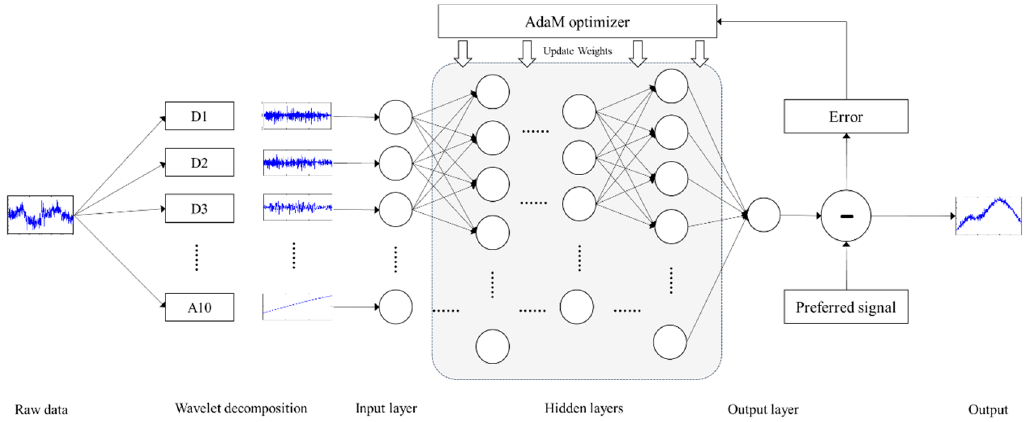
Figure 4. Structure of the proposed neural network.